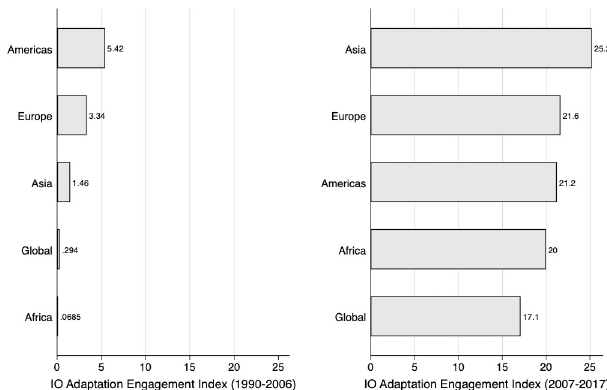
Fig 5. Average IO Engagement Index, by world region